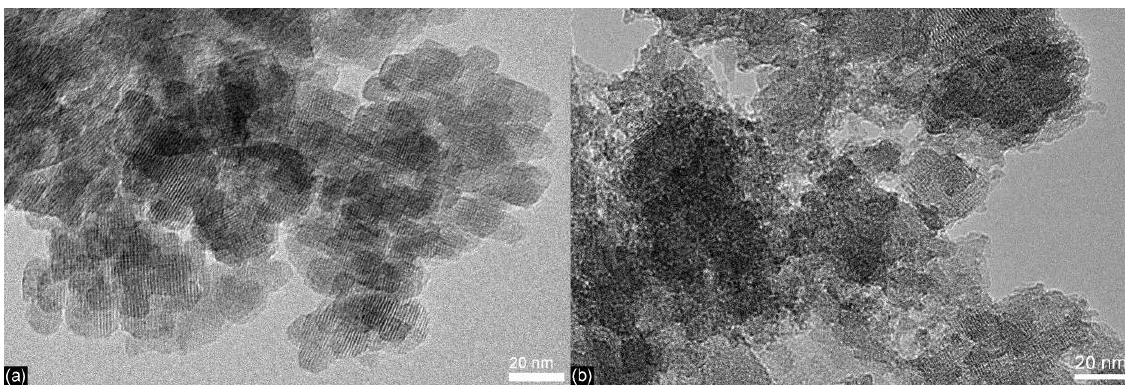
Figure 3. High-resolution TEM images of ( a ) Cr-BEA and ( b )